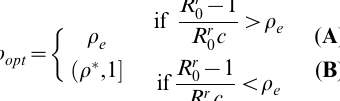
In case (A) , which corresponds to a high w and low c scenario, the CFP is stable with the wild-type and the resistant strains kept at low levels. In case (B) ( i.e. , low w and high c ), shifting the stability to the RFP is preferable since only the resistant strain will persist at low levels (see Figure 3). In other words, if the resistant strain features high relative transmissibility and resistance is rare, the best treatment regime would be at intermediate levels ( r e ) ; whereas if the opposite holds true, treating a larger fraction ( w r (cid:3) ) of the infected population is preferred.